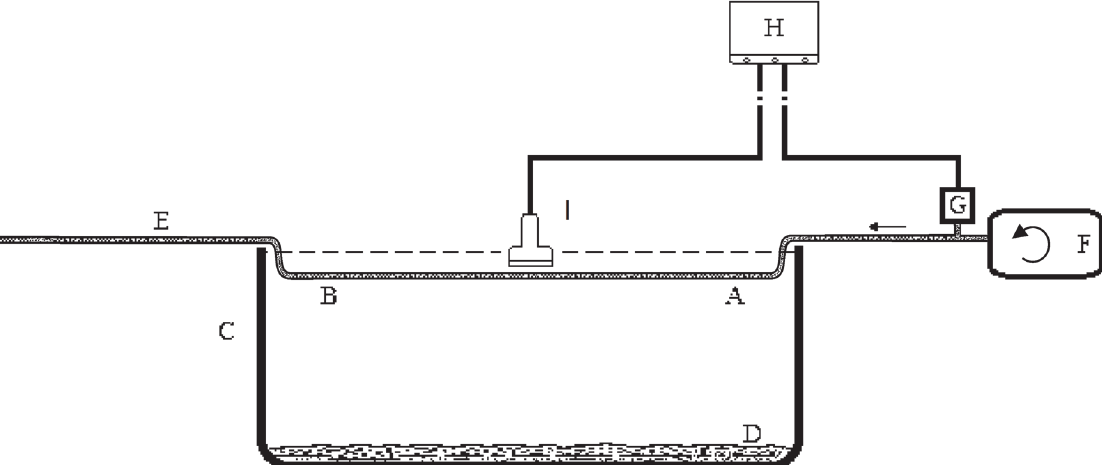
Fig 1. The sketch of the in vitro model. A and B, the two points chosen for the pulse wave velocity measurement; C, the water tank; D, a piece of sponge; E, the homogeneous rubber tubing; F, the perfusion pump; G, the pressure transducer; H, the ultrasound system; I, the linear array transducer. The pulse wave transit time between point A and B could be obtained by respectively recording the flow spectrum at point A and point B. The PWV of part A-B could be calculated as the distance between A and B could be easily measured. The local PWV of a short segment at the middle of point A and B could be measured using our method. And these two PWVs should theoretically be equal. PWV, pulse wave